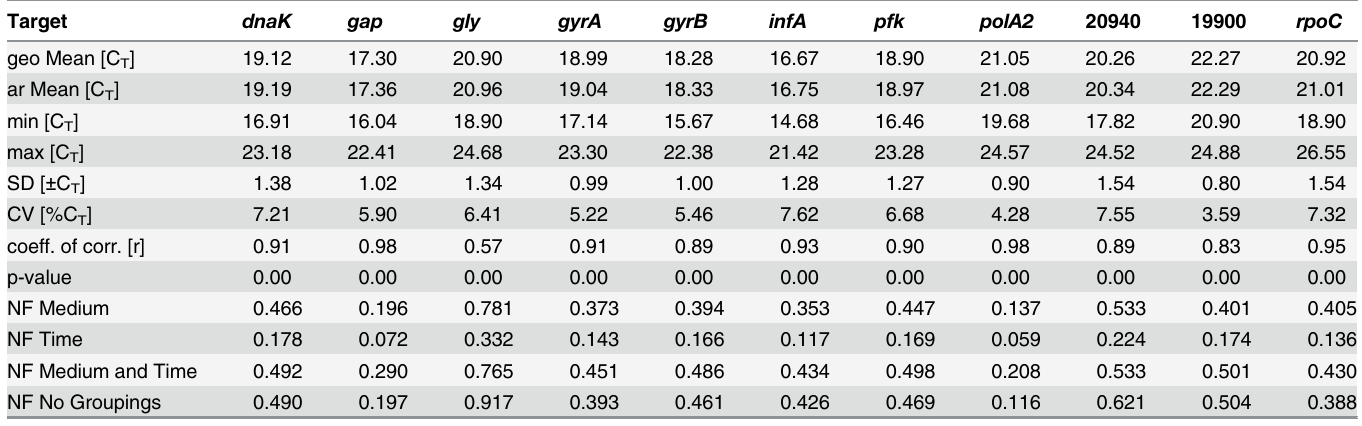
Table 3. Descriptive statistics and stability values of candidate reference genes under anaerobic (glucose, lactate) and aerobic (TYG) growth over time ( n = 24). Target